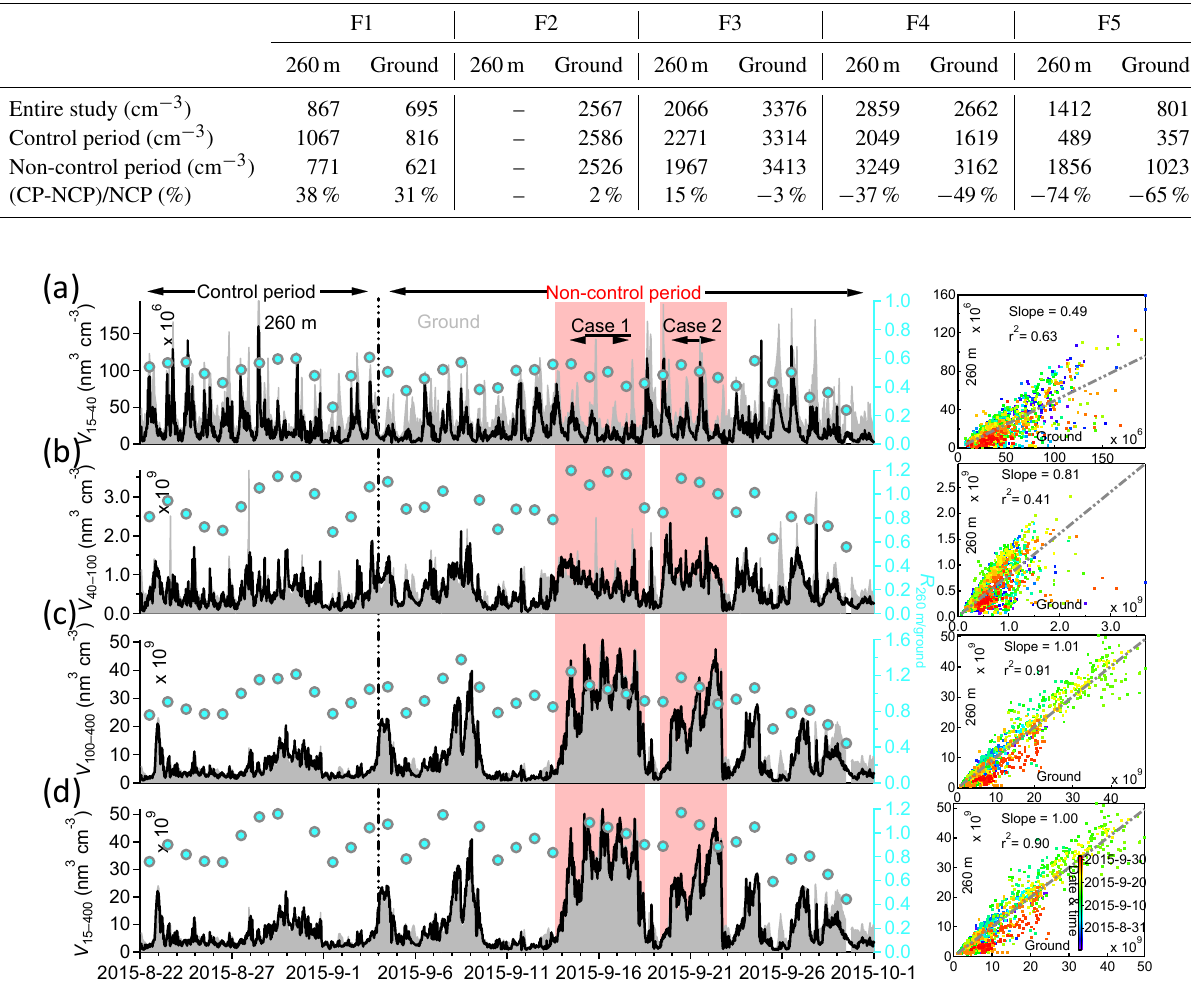
Figure 3. Comparisons of particle volume concentrations between ground level and 260m for different size ranges, i.e., (a) small Aitken mode (15–40nm), (b) large Aitken mode (40–100nm), (c) accumulation mode (100–400nm), and (d) the total number of particles (15– 400nm). Right figure show the scatter plots of the